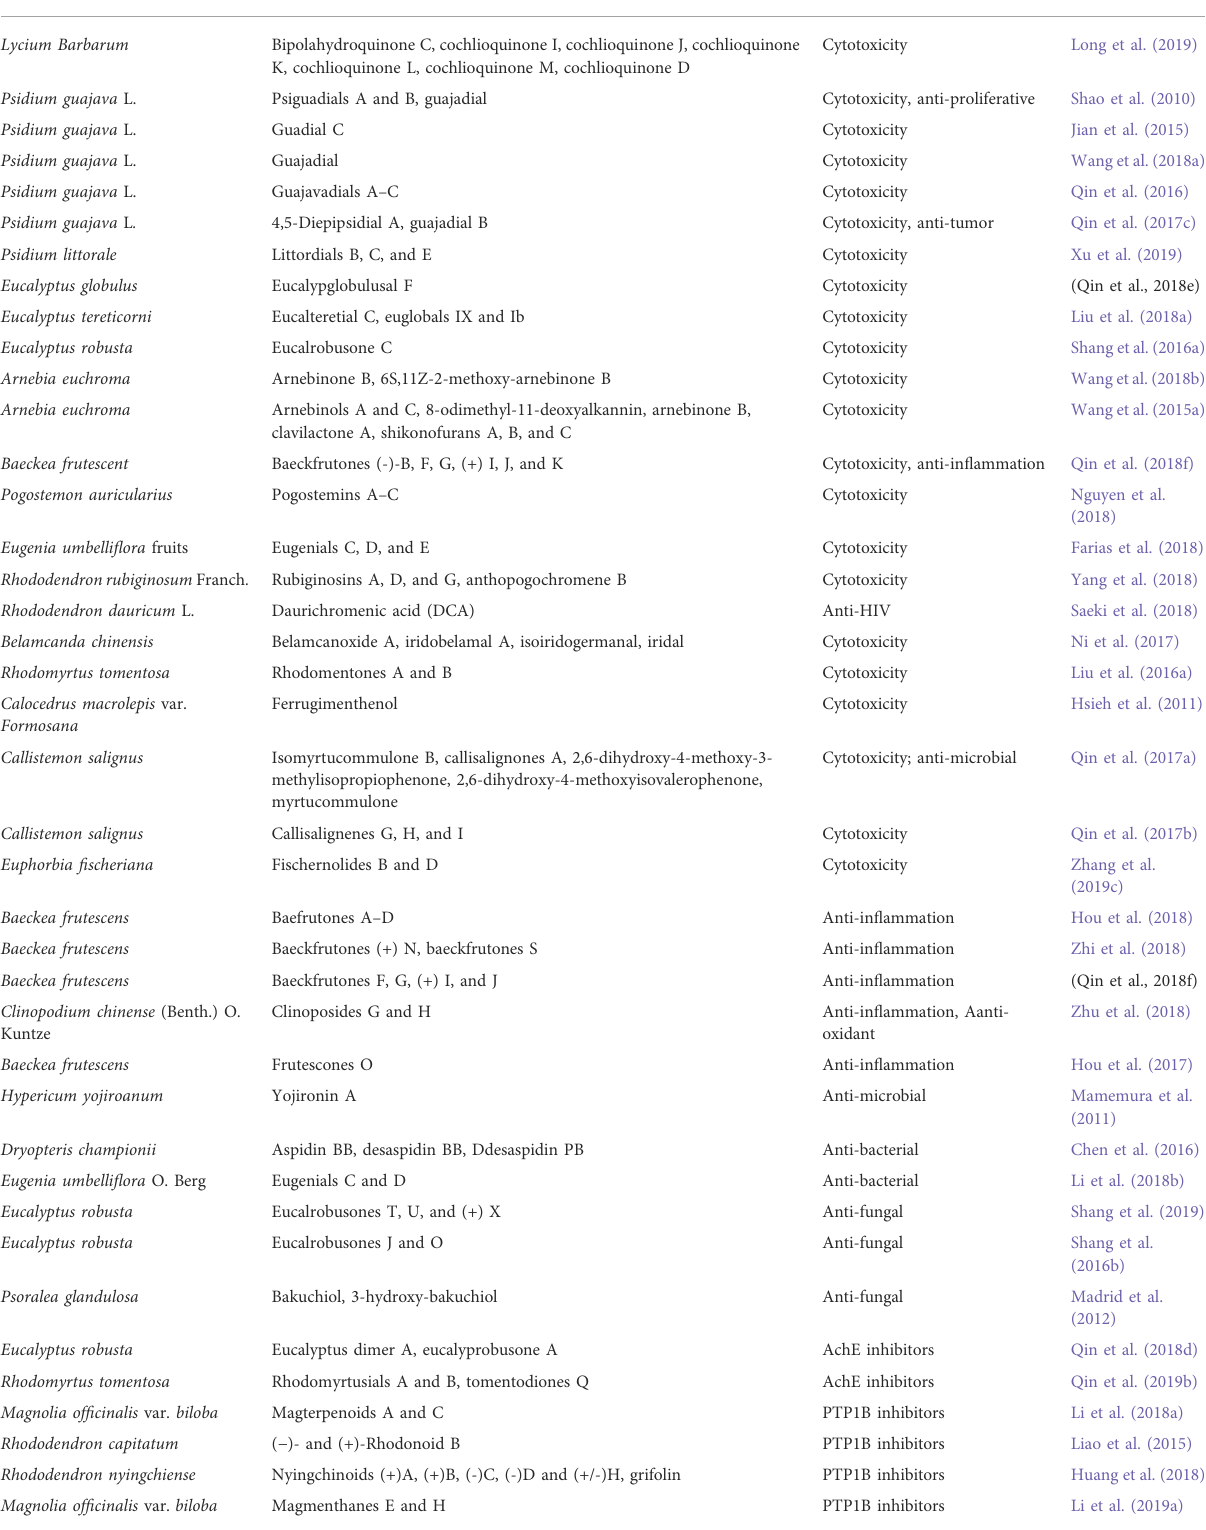
TABLE 3 Sources and biological activity of plant